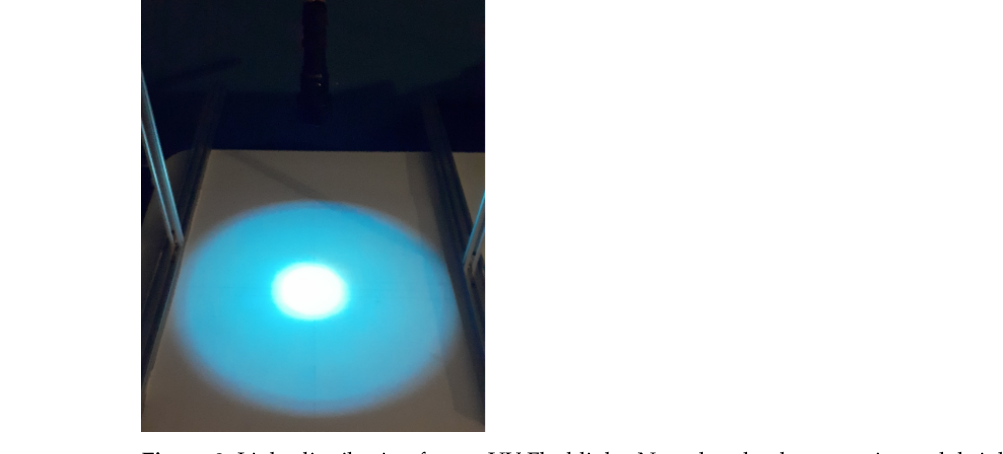
Figure 8. Light distribution from a UV Flashlight. Note that the the center is much brighter than the edges, and that the intensity does not change smoothly with the distance from the center.